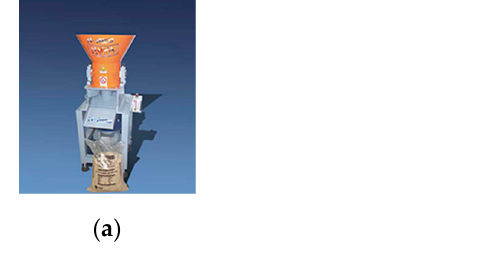
Figure 3. N-Pico pelletizer ( a ) and pelletized rice straw (RS) ( b ).